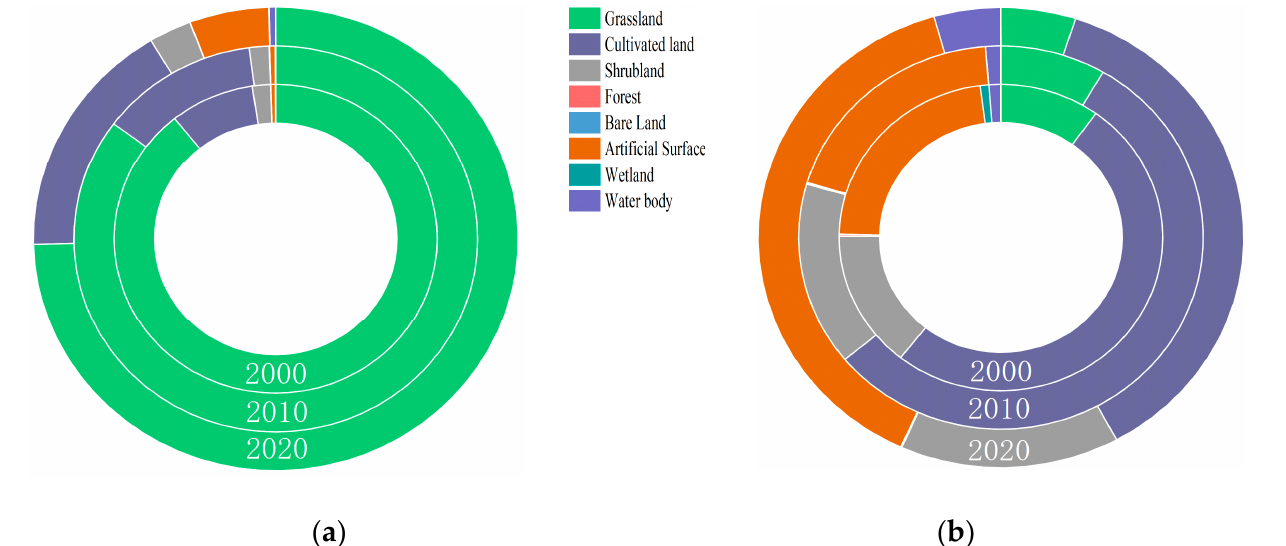
Figure 2. Ratio (%) of the area of land use/cover to the total area of alluvial fans or to the corresponding land use/cover in LRB. ( a ). Ratio to the total area of alluvial fans; ( b ). Ratio to the corresponding land use/cover in LRB.